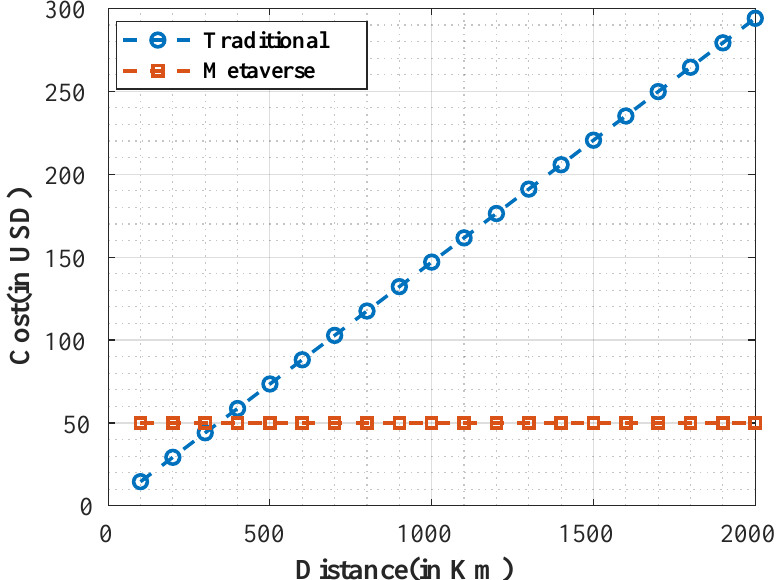
Figure 9. Cost of evaluating a land in the